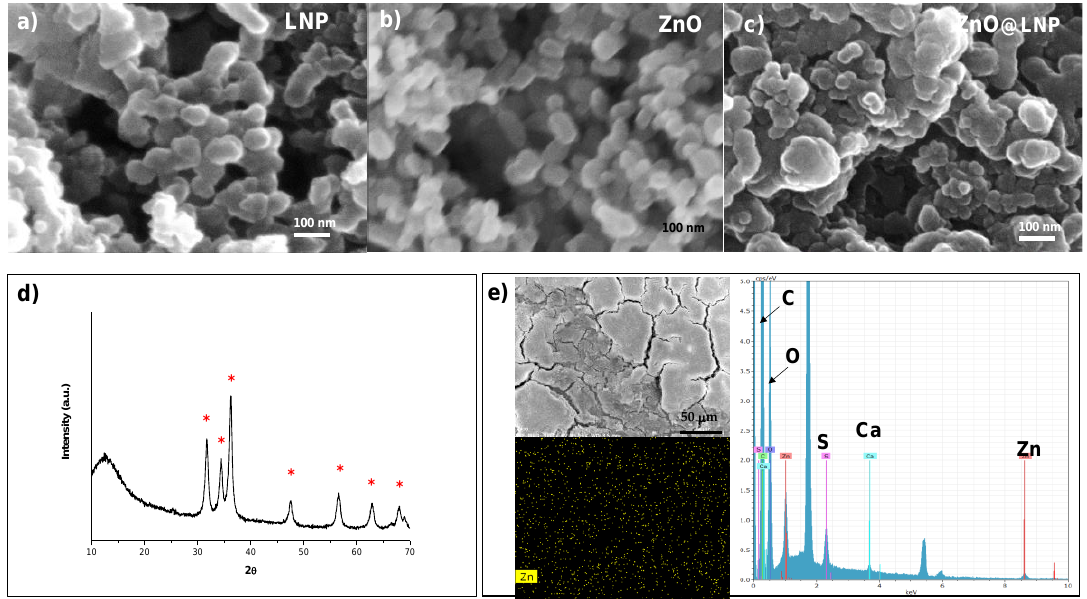
Figure 1. ( a ) Field-emission scanning electron microscopy (FESEM) images of lignin nanoparticles (LNP), ( b ) ZnO and ( c ) ZnO@LNP nanoparticles. X-ray diffraction (XRD) patterns ( d ) and Energy Dispersive X-Ray (EDX) analysis ( e ) of ZnO@LNP.